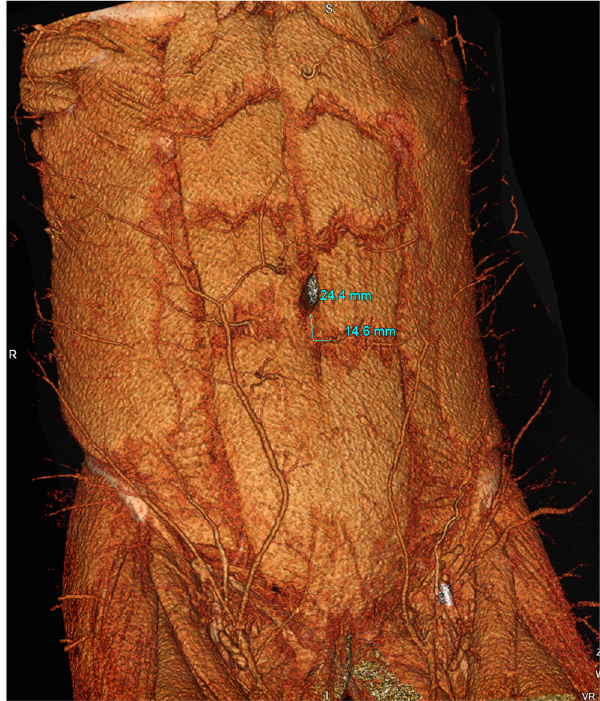
Fig. 18 A 45-year-old woman with breast cancer undergoes a CT deep inferior epigastric artery perforator (DIEP) protocol prior to breast recon- struction.Coronal oblique 3D segmented VR image fromthe CT displays the abdominal wall musculature and superficial arterial supply. The loca- tion of the largest DIEP relative to the umbilicus is annotated with craniocaudal and mediolateral distance measurements to help the surgeon locate the vessel during